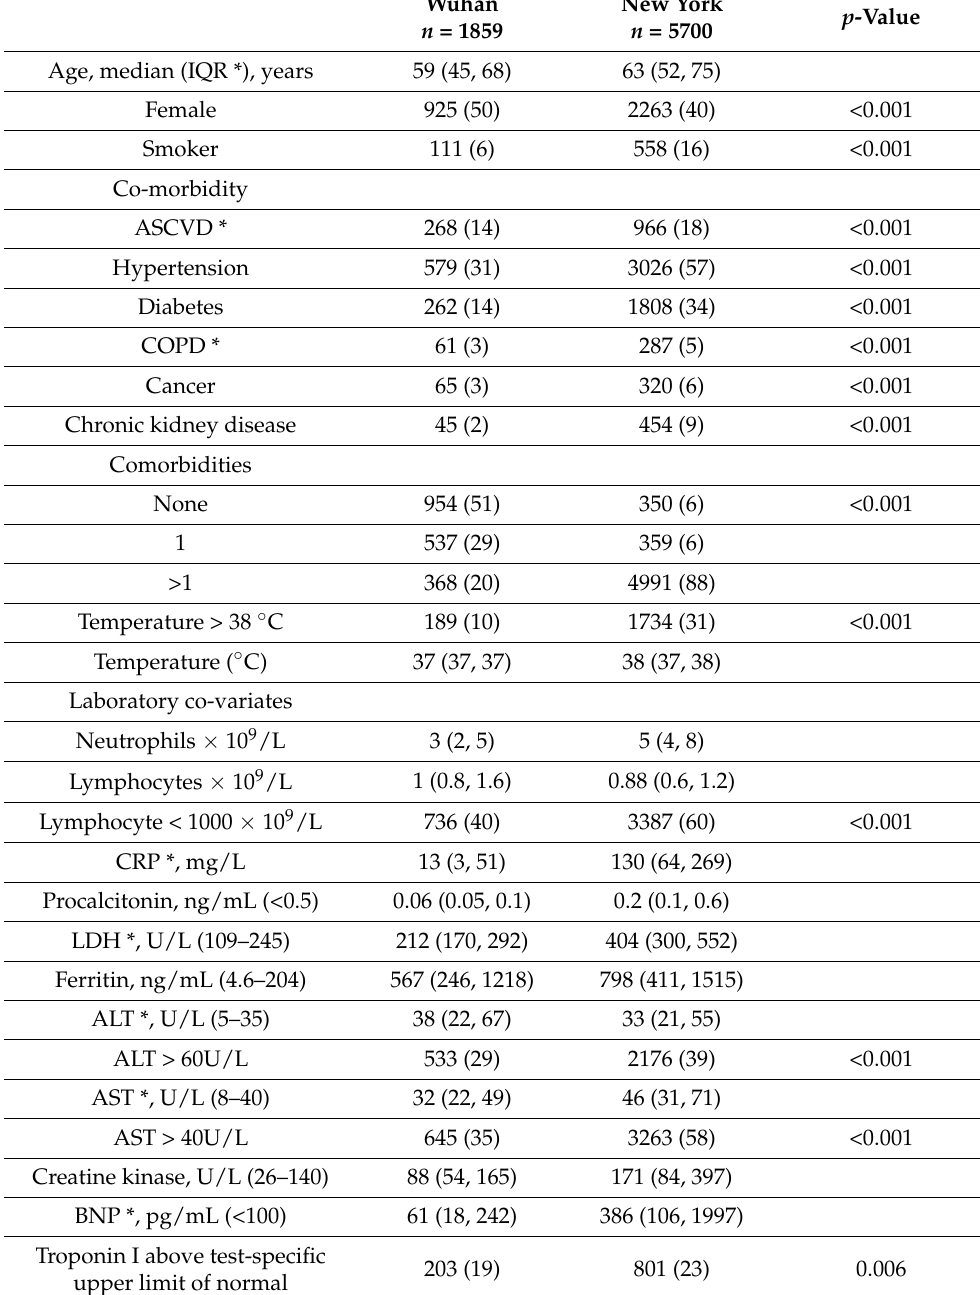
Table 1. Hospital admission